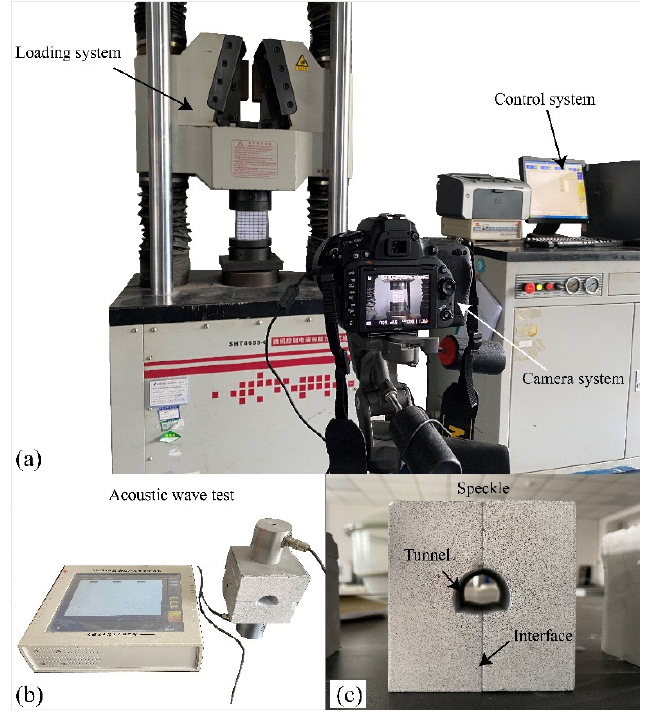
Figure 3. Apparatus. ( a ) is the loading machine and camera system. ( b ) is the ultrasonic tester. ( c ) shows the speckles on the sample surface.